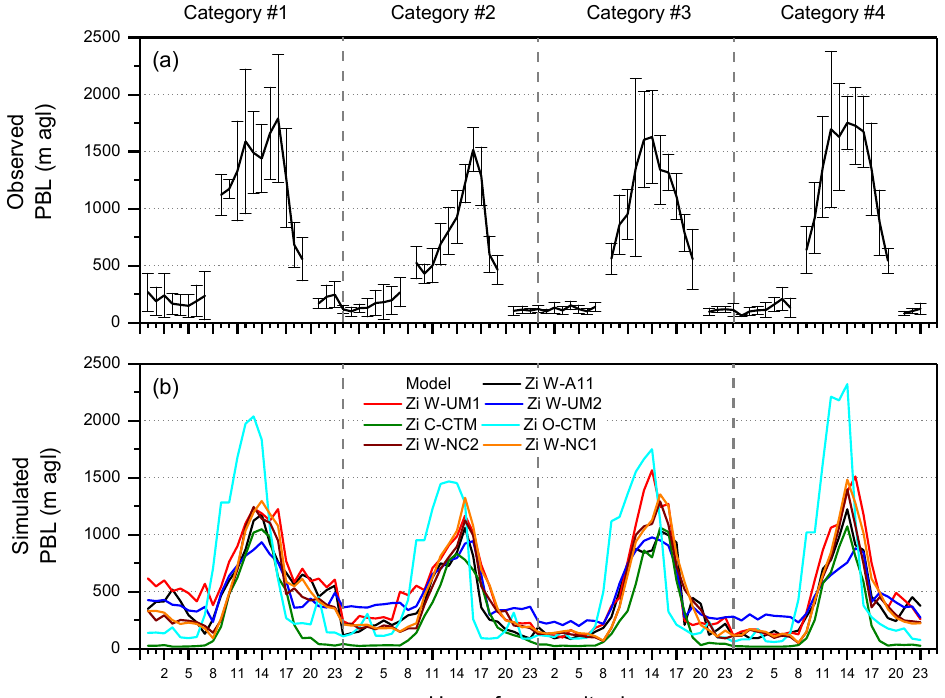
Figure 10. Diurnal composite ( a ) observed (lidar) and estimated ( h e —radon) mixing depths, and ( b ) simulated ABL depths from each model, for each of the radon-derived mixing categories at Westmead for the whole SPS-II